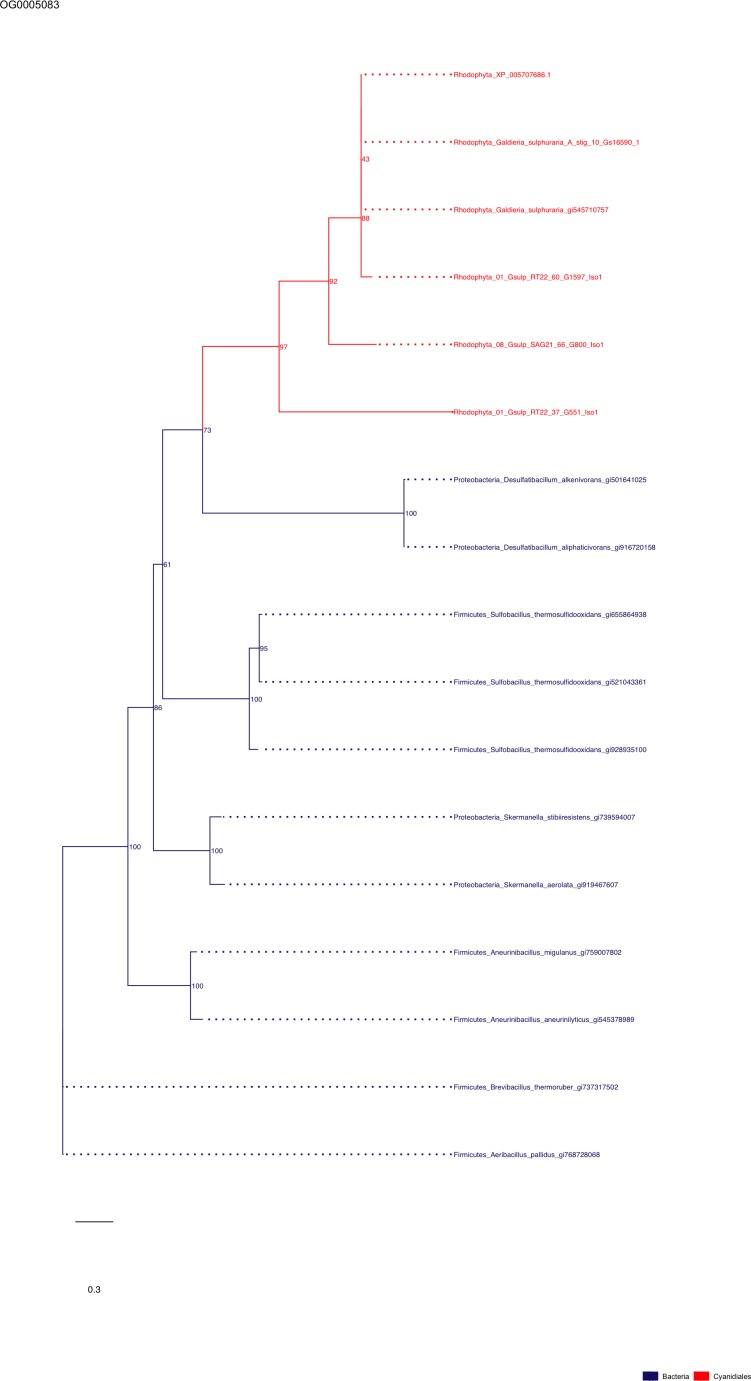
Sequence tree of orthogroup OG0005083.The tree is based on amino acid sequences. Archaea (yellow), Bacteria (blue), Cyanidiales (red), Eukaryotes including other red algae (green). Branches containing Cyanidiales sequences are highlited in red.